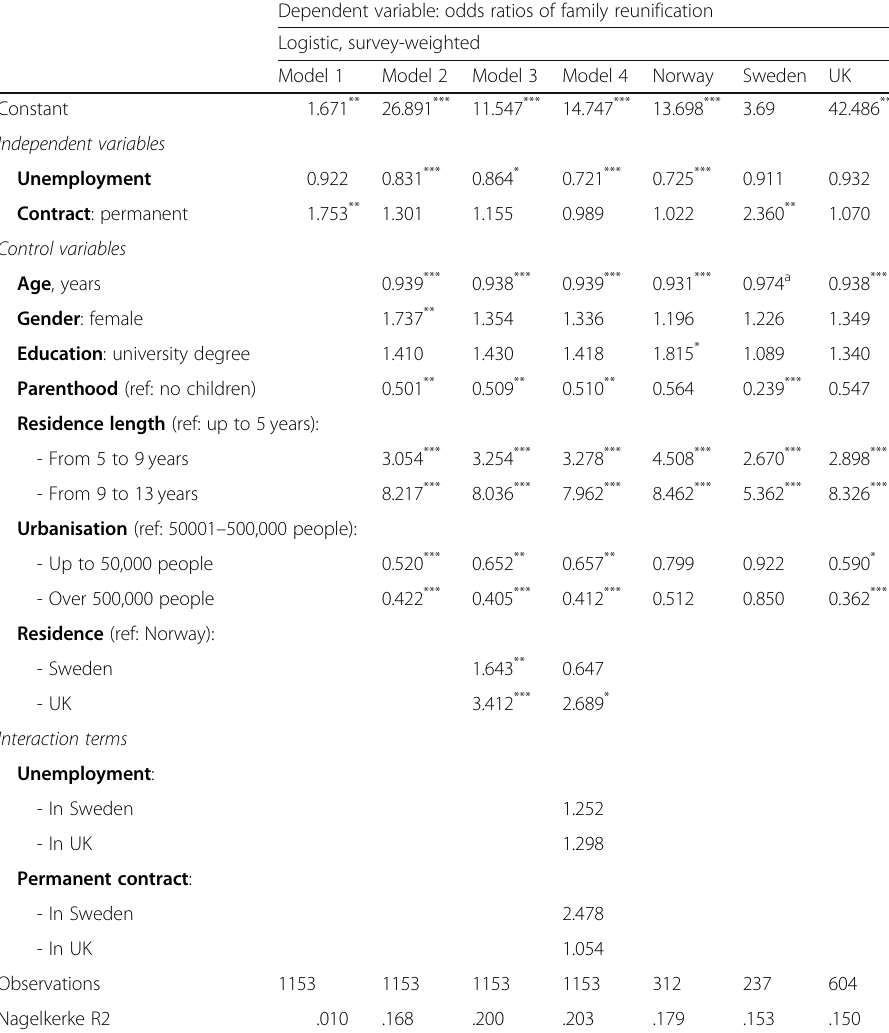
Table 5 Multivariate results: models 1 – 4 and separate models for Norway, Sweden, and the UK Dependent variable: odds ratios of family